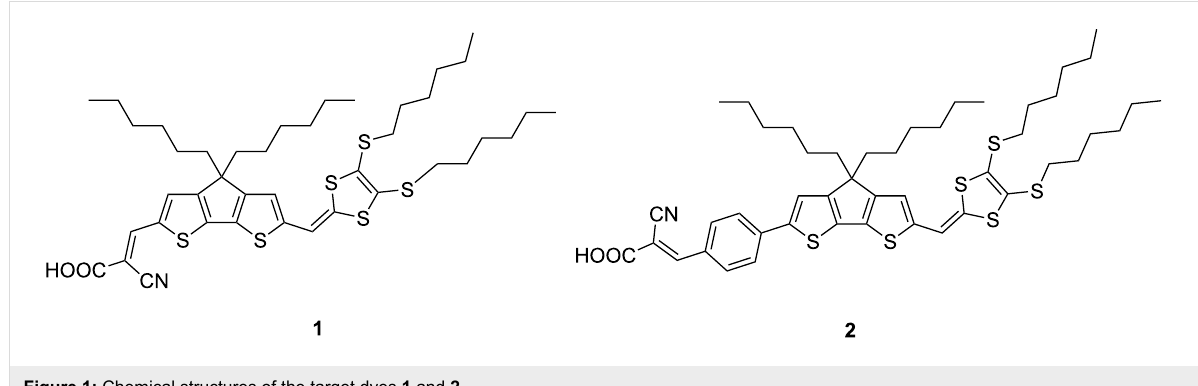
Figure 1: Chemical structures of the target dyes 1 and 2 .